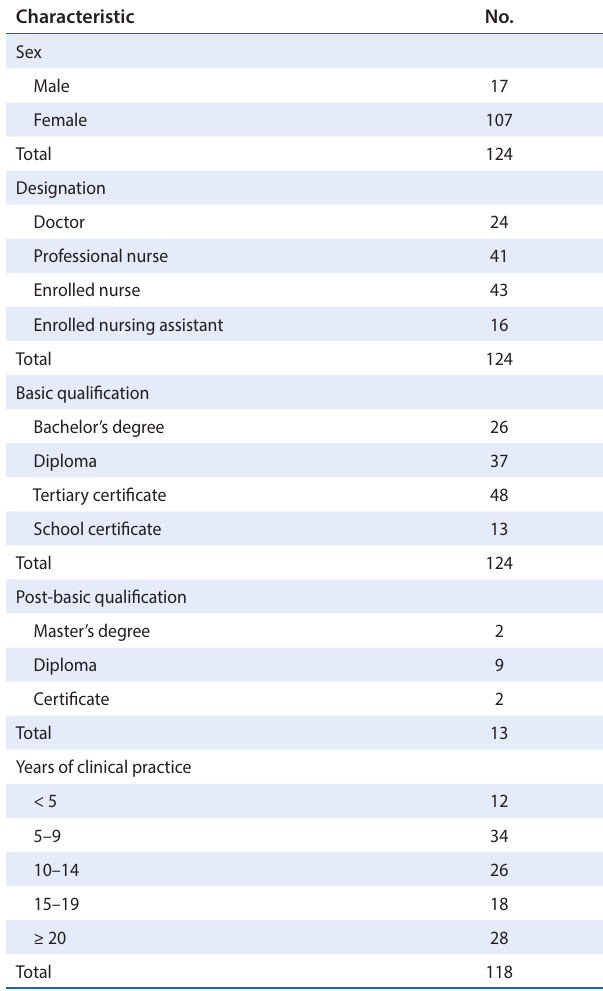
Table 1: Demographic characteristics of respondents